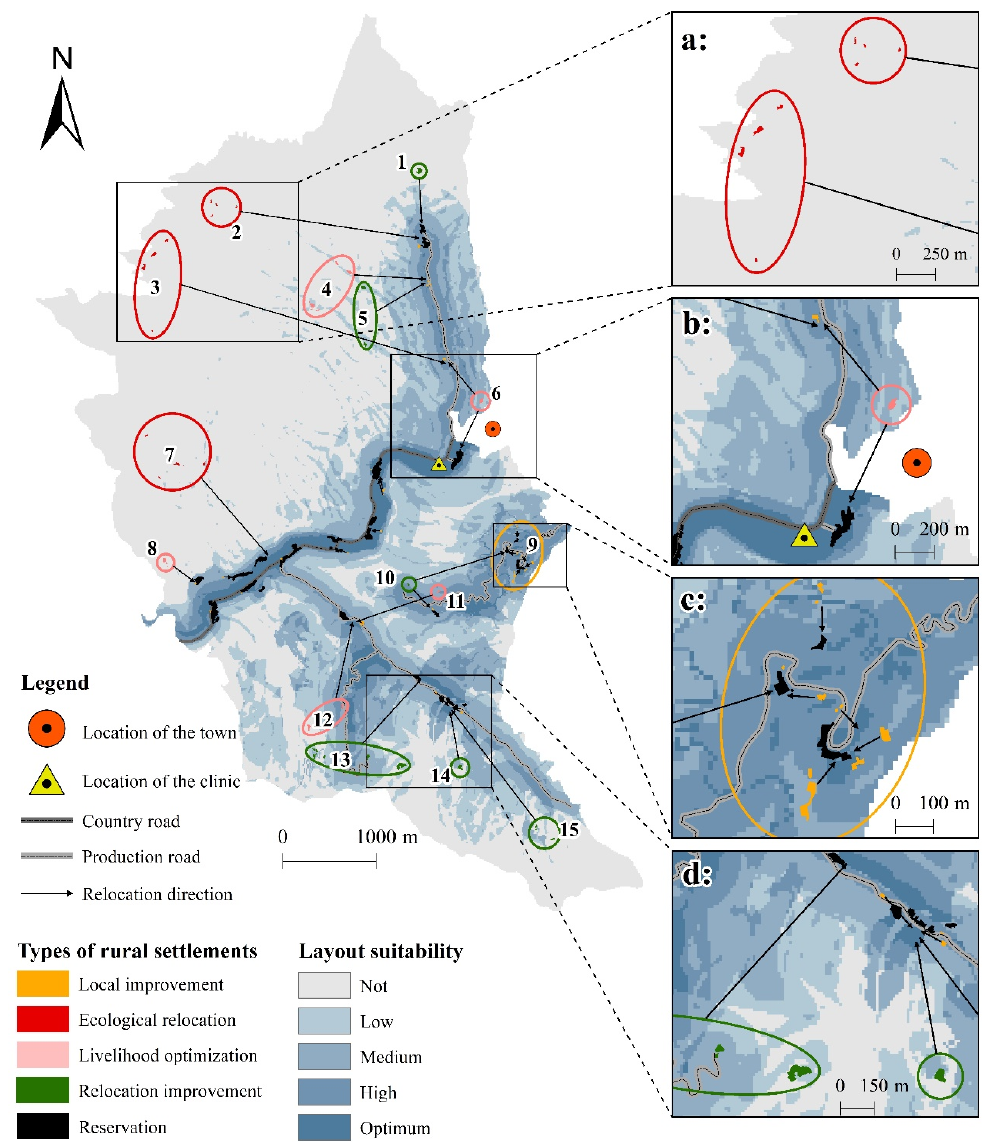
Figure 4. Rural settlement reconstruction scheme in the village of Pingba.